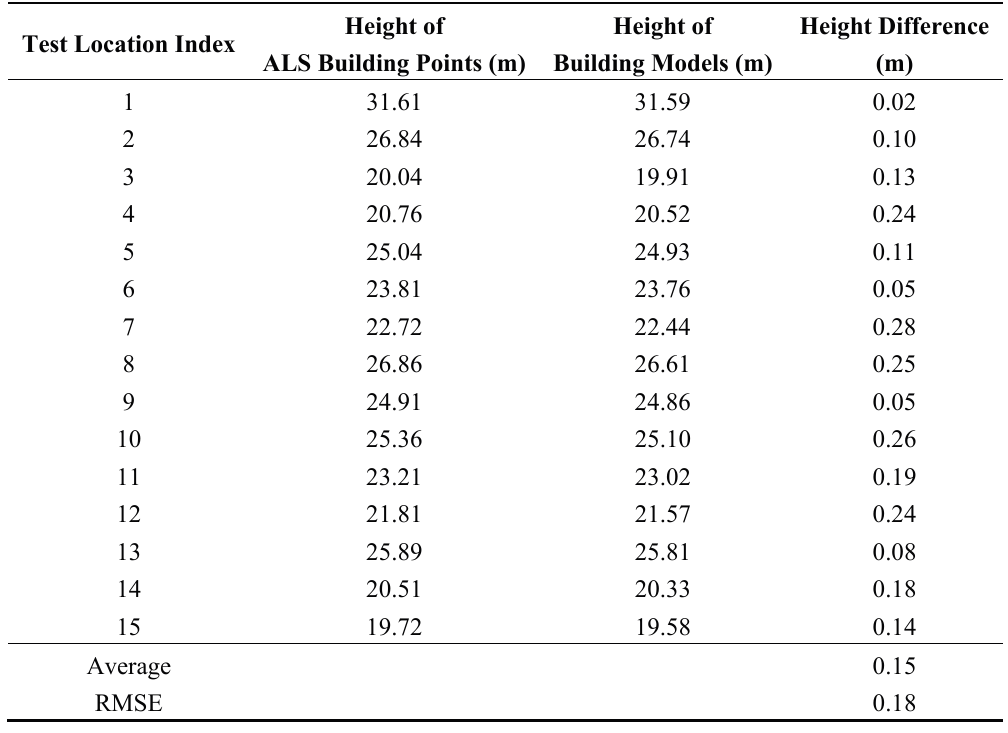
Table 3. Height differences between the ALS building roof points and 3D roof models in 15 test